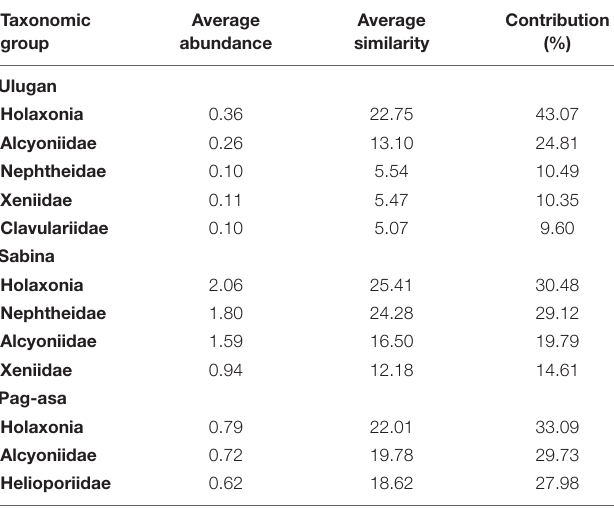
TABLE 4 | Summary result of the Similarity of Percentages (SIMPER) analysis among sites in the Kalayaan Island Group and Ulugan in 2019. Taxonomic Average group abundance